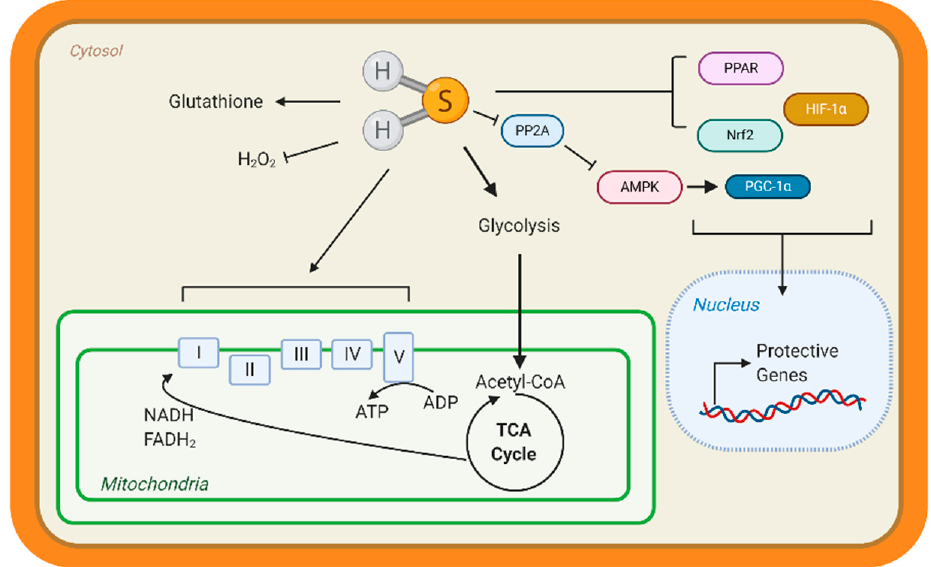
Figure 3. Hydrogen sulfide (H2S) Metabolic Targets in the Heart. Few studies have identified metabolic targets of H2S, but those that have been identified are key for cardiac metabolism. H2S can modify free cysteines on enzymes, a reaction known as S-sulfhydration, to alter metabolic pathways, such as glycolysis, and induce up-regulation of metabolic genes via transcription factor activation. Peroxisome proliferator-activated receptors (PPAR), hypoxia-inducible factor 1 α (HIF- 1 α ), and nuclear factor E2-related factor 2 (Nrf2) are transcription factors known to be S-sulfhy- drated and regulate heart metabolism. H2S also modified the complexes of the Electron Transport Chain and can stimulate mitochondrial respiration. H2S is considered an antioxidant molecule because it can react with glutathione and hydrogen peroxide (H2O2). Finally, our group found that S-sulfhydration represses protein phosphatase 2A (PP2A) activity, allowing for the activation of adenosine monophosphate kinase (AMPK) and phosphorylation of the transcription factor pe- roxisome proliferator-activated receptor γ coactivator-1 α (PGC-1 α ) to induce gene expression.